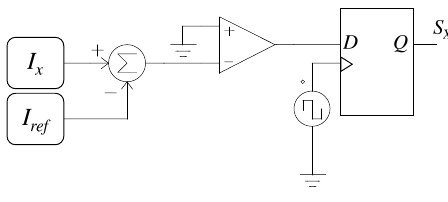
Figure 18. Current